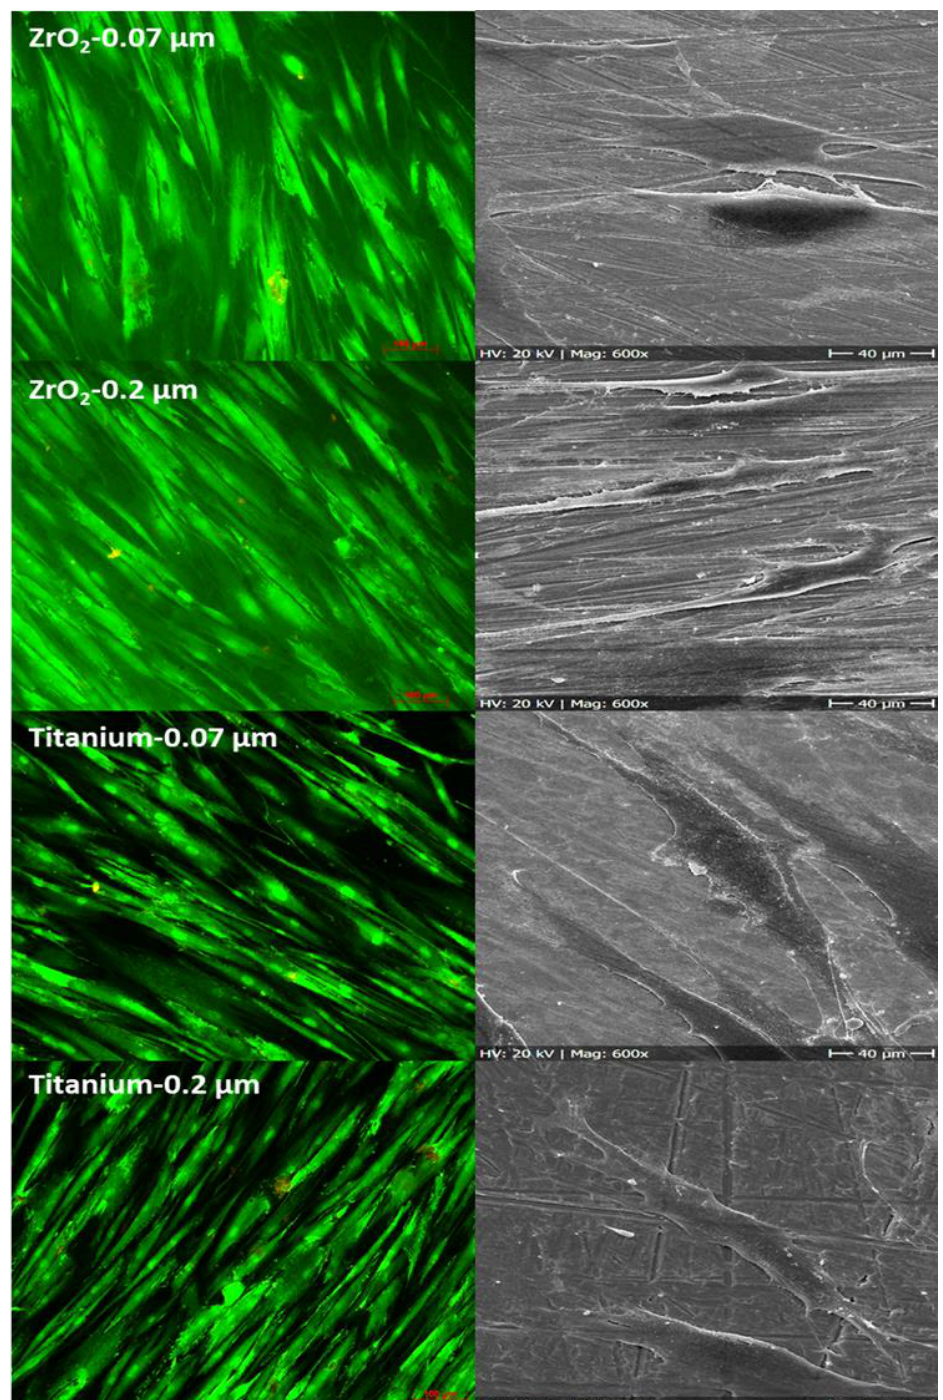
Figure 4 . HGF-1 cells growing on zirconia and on titanium at day 1 (left site = living/dead staining, magnification factor ×100, size bare 100 µm; right site = SEM, magnification factor ×600, size bare 40 µm).